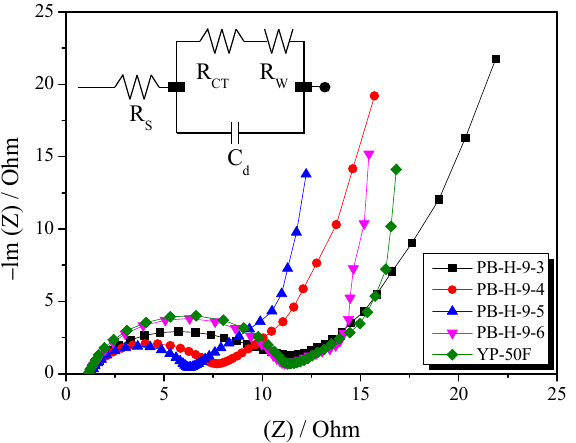
Figure 9. Nyquist plots of bamboo-derived activated carbon materials obtained using different steam activation conditions and its equivalent circuit is shown in inset.